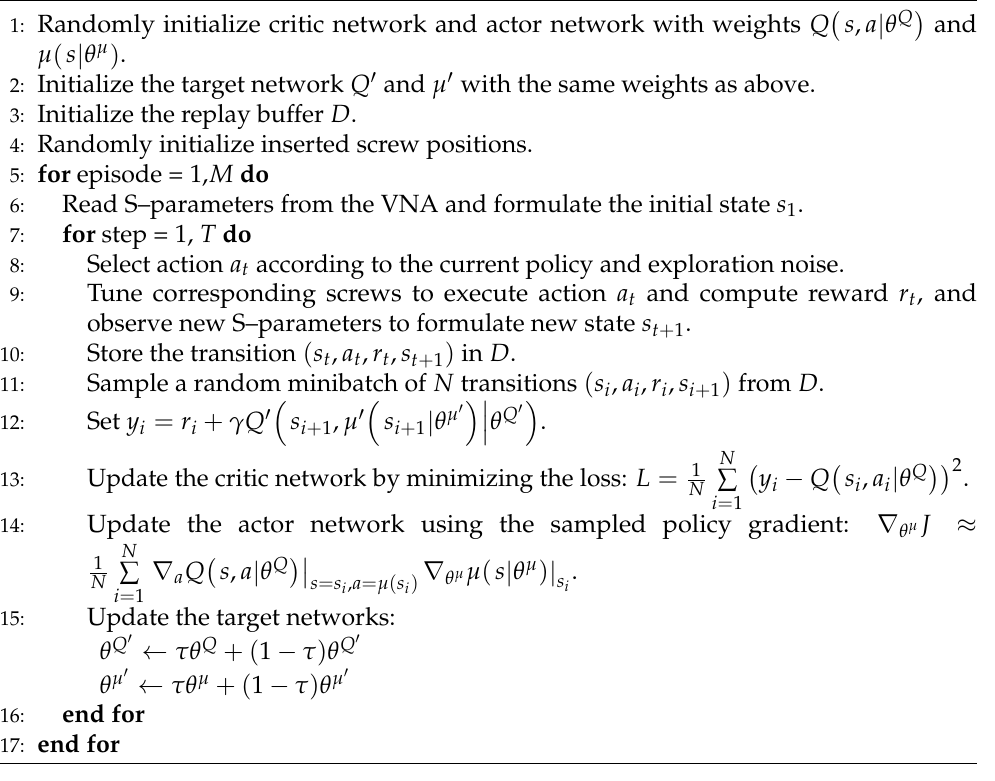
Algorithm 1 Intelligent Tuning Based on